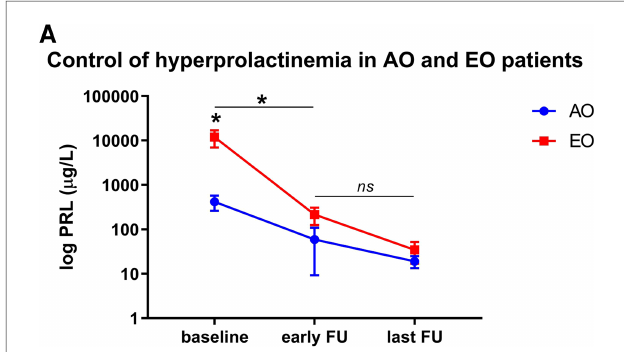
FIGURE 2 PRL levels in adolescent-onset (AO) patients and elderly onset (EO) patients. ( A ) Differences in PRL levels in both cohorts at baseline, early (i.e. 3 months) and last follow-up. Baseline PRL levels were signi fi cantly higher in patients in the EO cohort than the AO cohort ( p =0.05), but not at early ( p =0.20) or long-term follow-up ( p =0.39). PRL levels at early follow-up signi fi cantly decreased in both cohorts compared to baseline values ( p =0.04 both in the AO and EO cohort). There is no signi fi cant difference between early and long-term PRL values ( p =0.48 for AO; p =0.07 for EO,